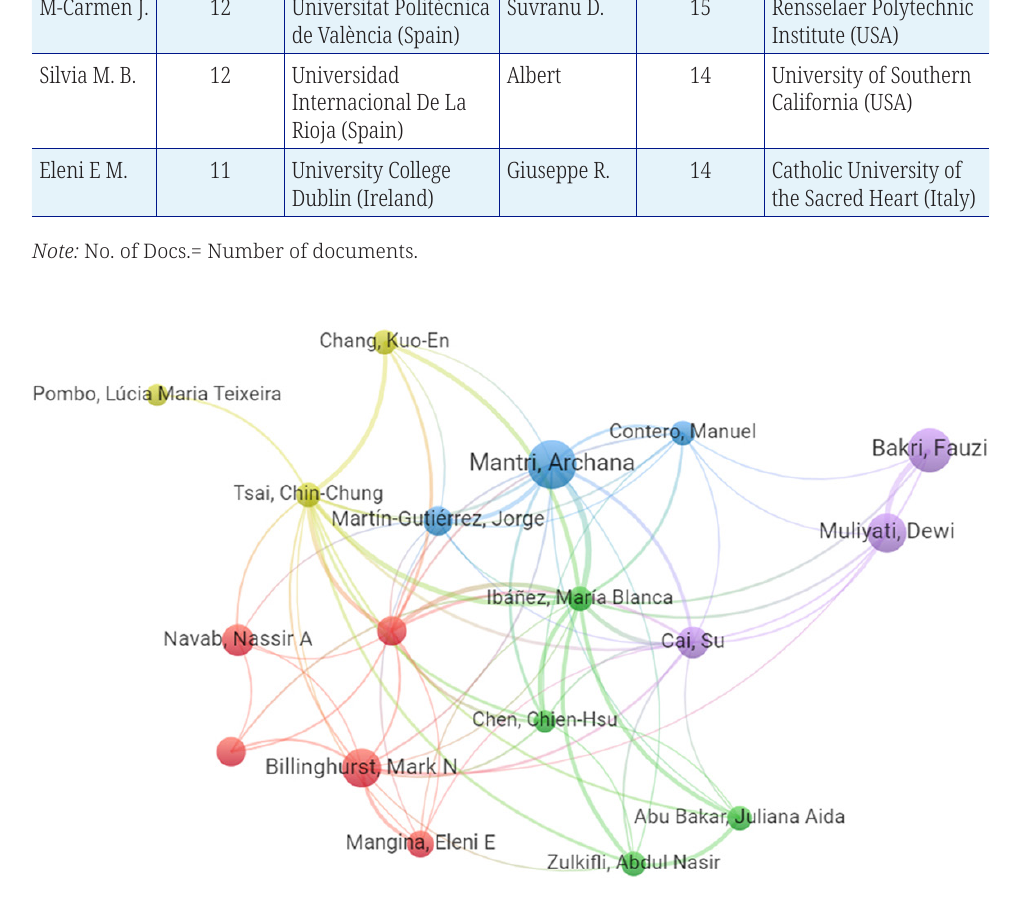
Fig. 11. Top authors with most publications: AR for learning (VOSViewer)